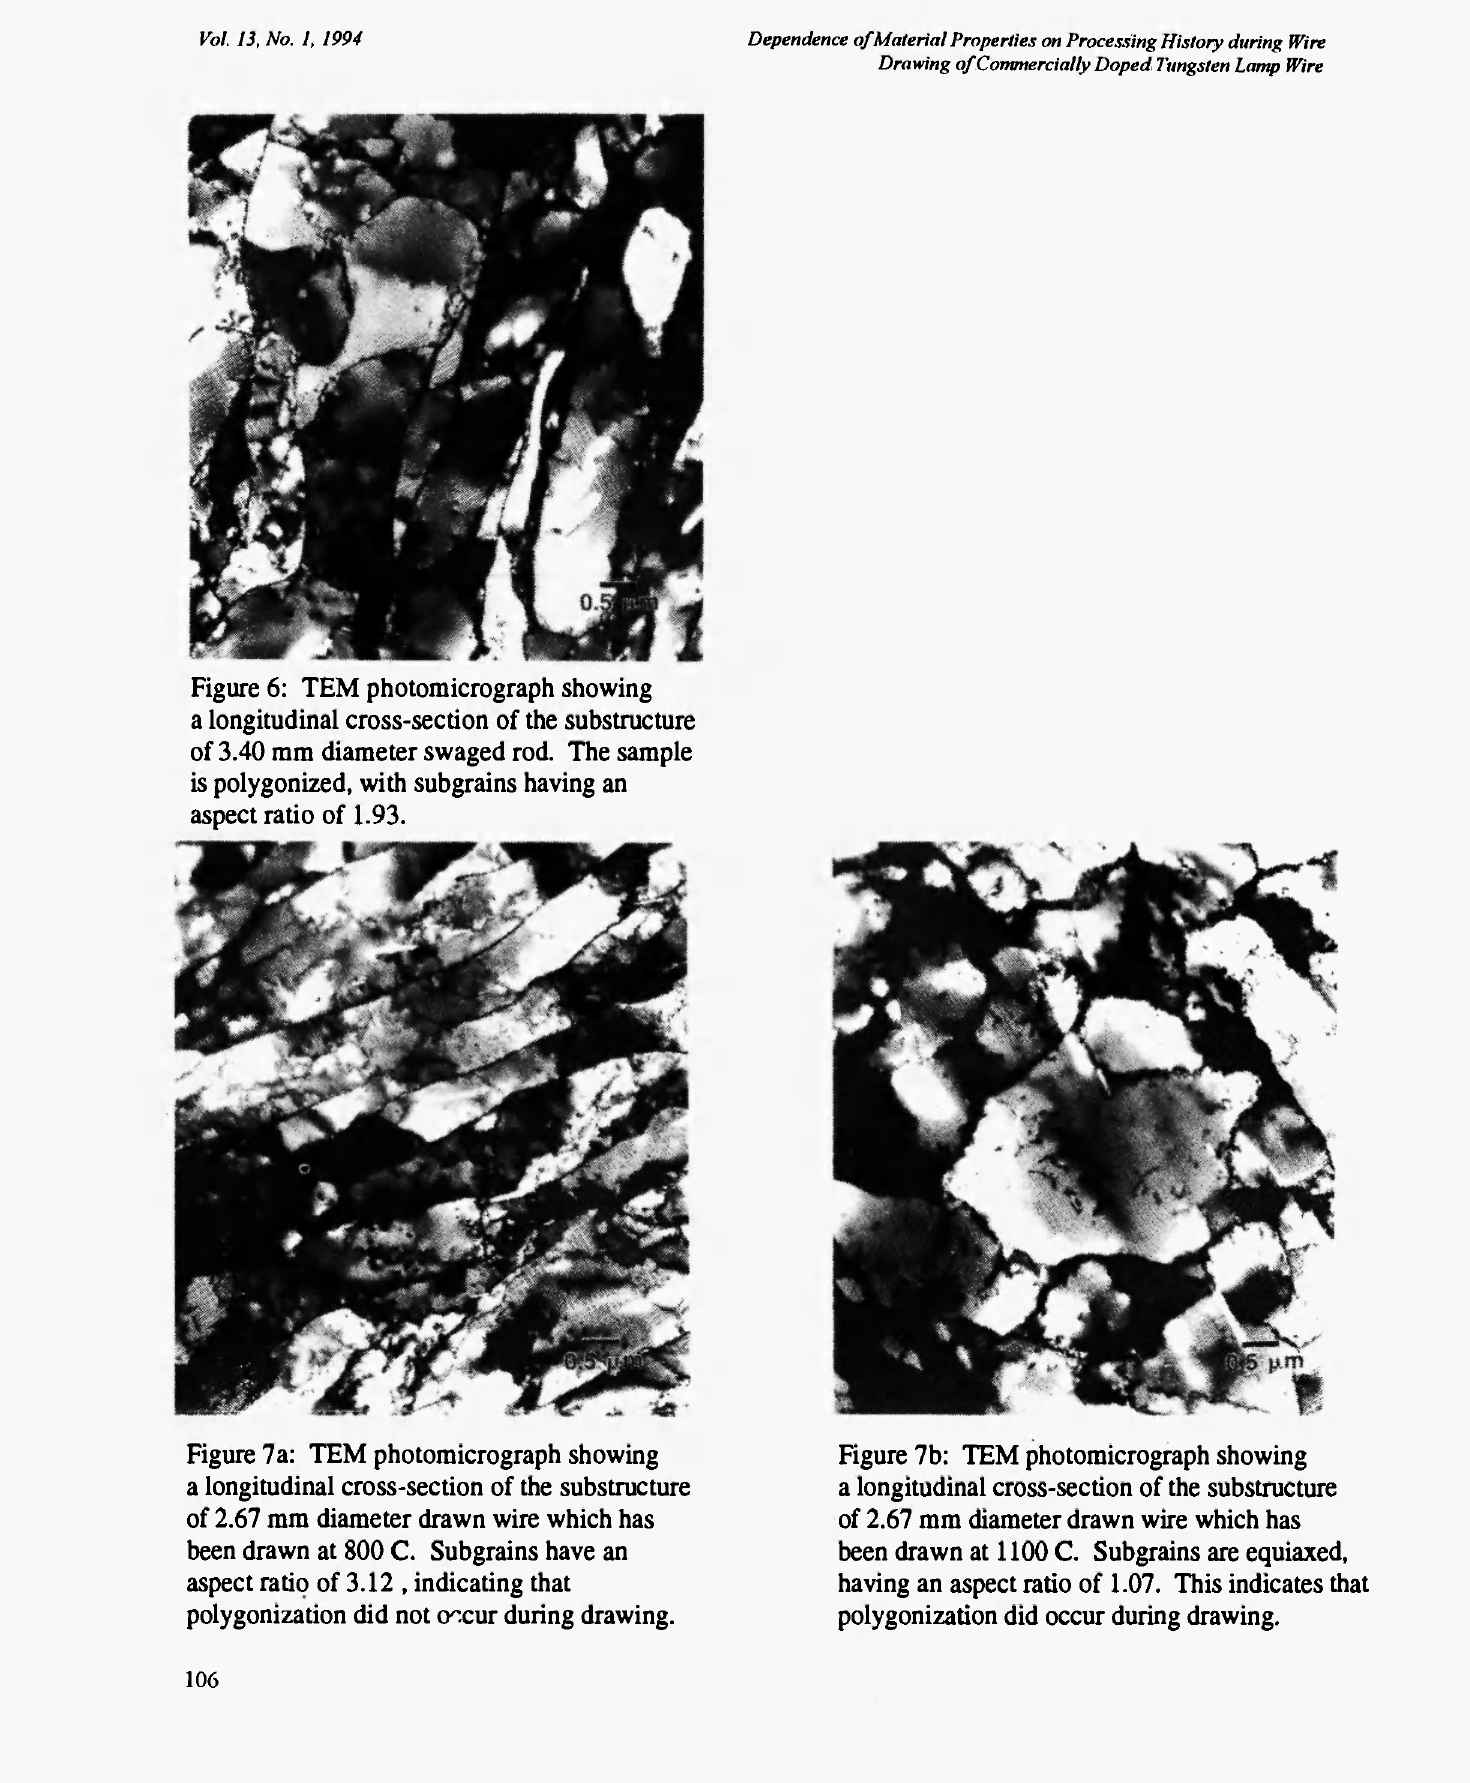
Figure 7b: TEM photomicrograph showing a longitudinal cross-section of the substructure of 2.67 mm diameter drawn wire which has been drawn at 1100 C. Subgrains are equiaxed, having an aspect ratio of 1.07. This indicates that polygonization did occur during